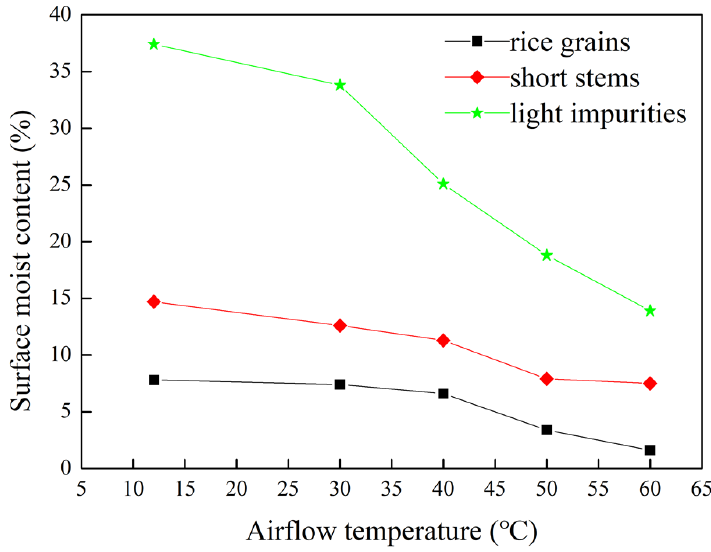
Figure 9. Curves of surface moisture content vs. temperature ( v = 7.60 m/s and t = 8 s).